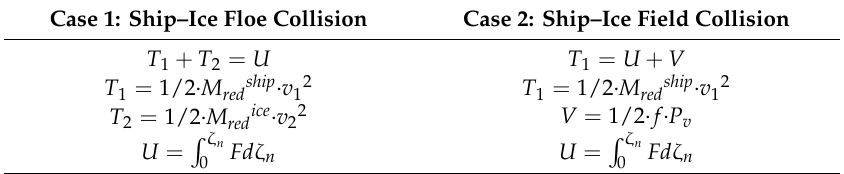
Table 1. Energy components of the Popov Method as determined based on Popov et al. [9]). Case 1: Ship–Ice Floe Collision Case 2: Ship–Ice Field